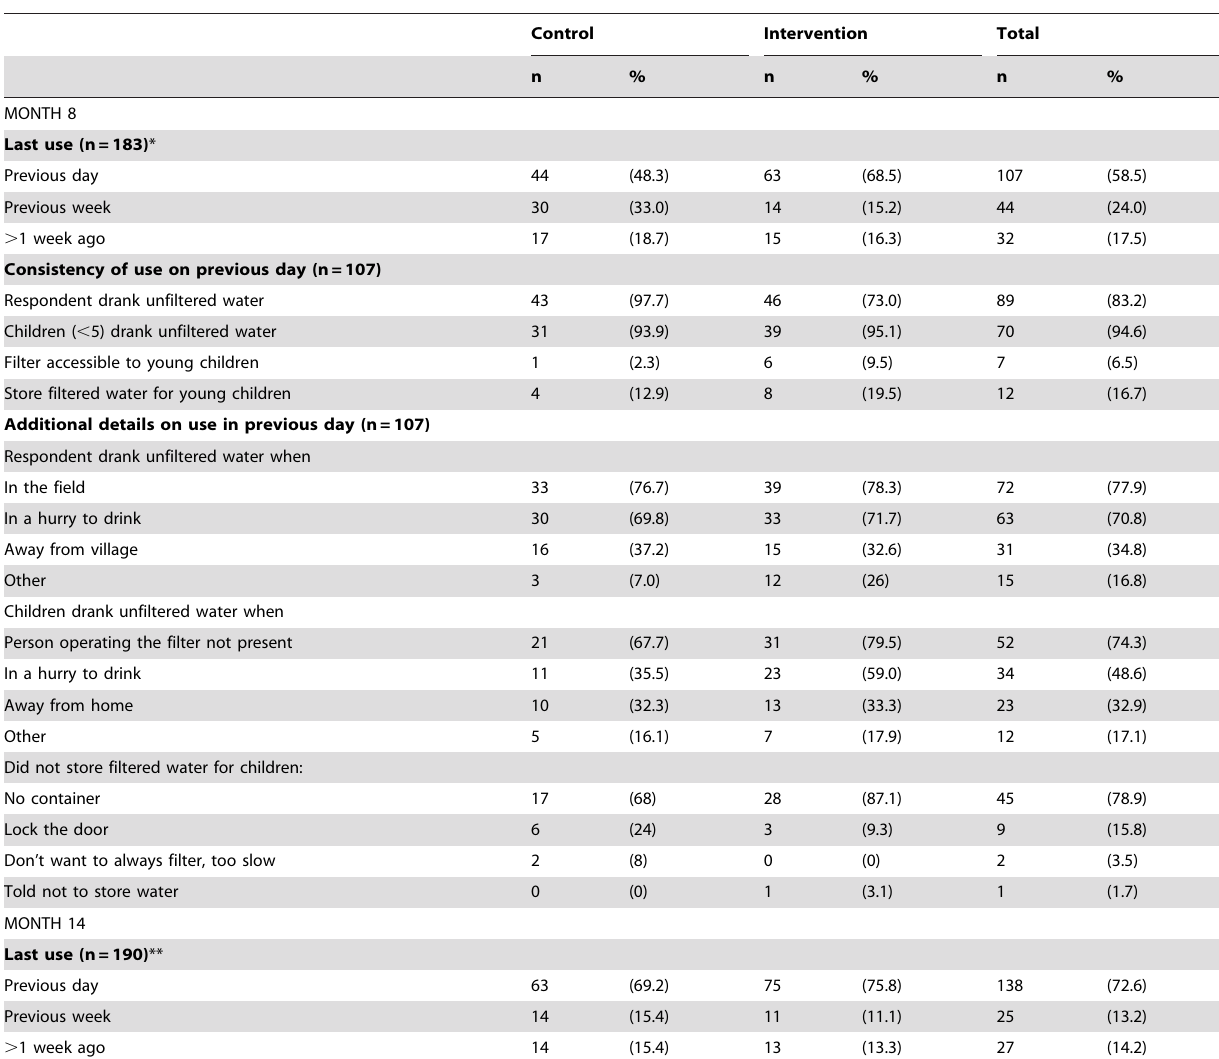
Table 3. Description of use among study participants.